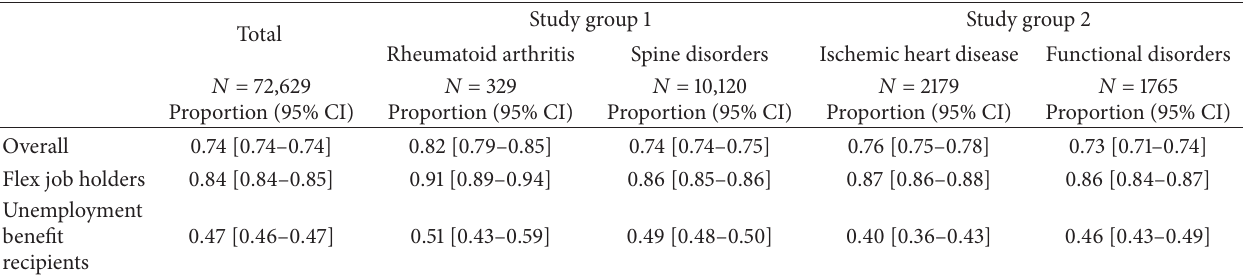
Table 3: Degree of employment ( employment time ratio ∗ ) in the flex job scheme before disability pension for different diagnoses stratified for employment status at